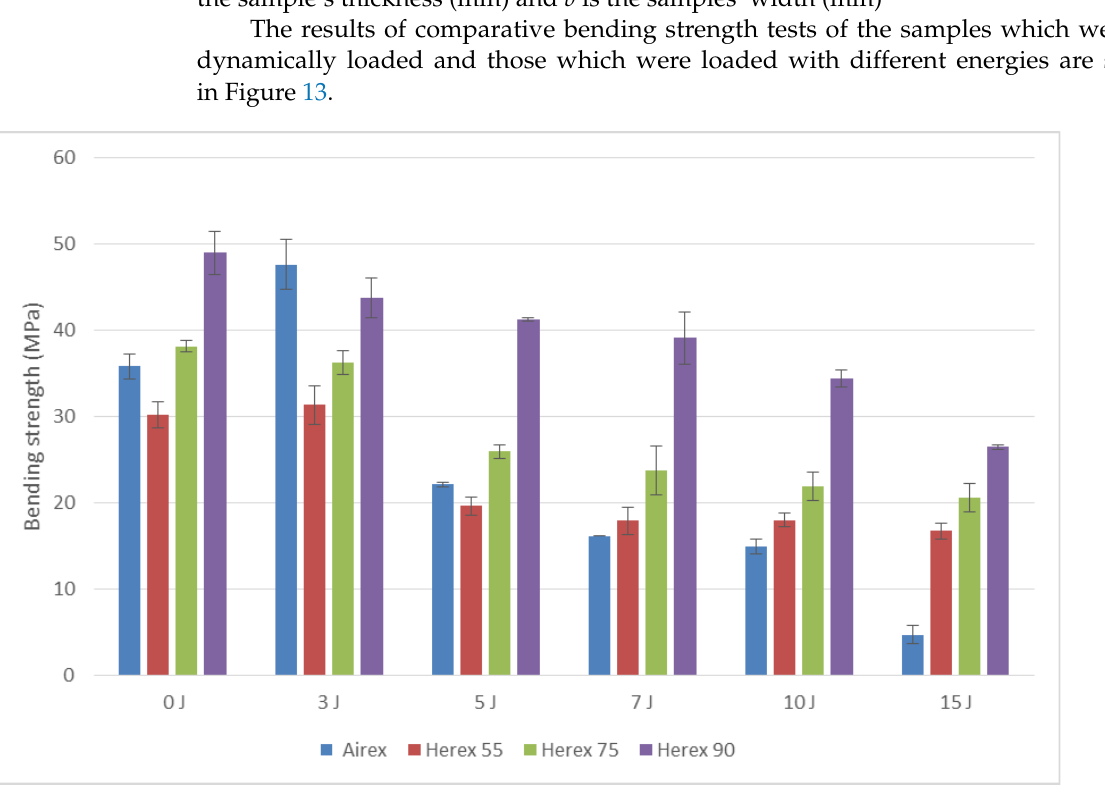
Figure 14. Sample for core strength testing.